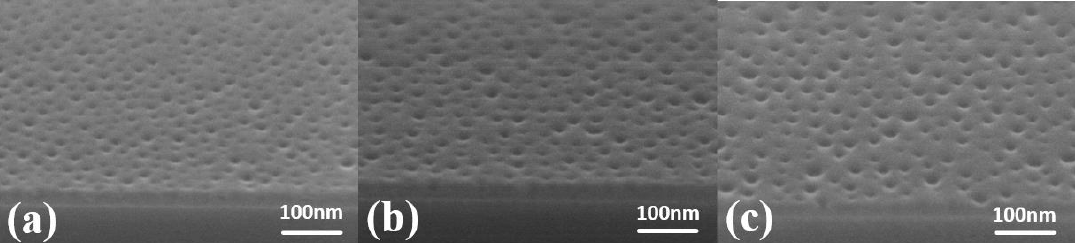
Figure 5. SEM images of blends materials phase separation results. The annealing temperature is 130 °C, and the annealing time is 30 min: ( a ) sample no. 1; ( b ) sample no. 2; ( c ) sample no. 3. The vacuum degree is − 0.1 MPa.